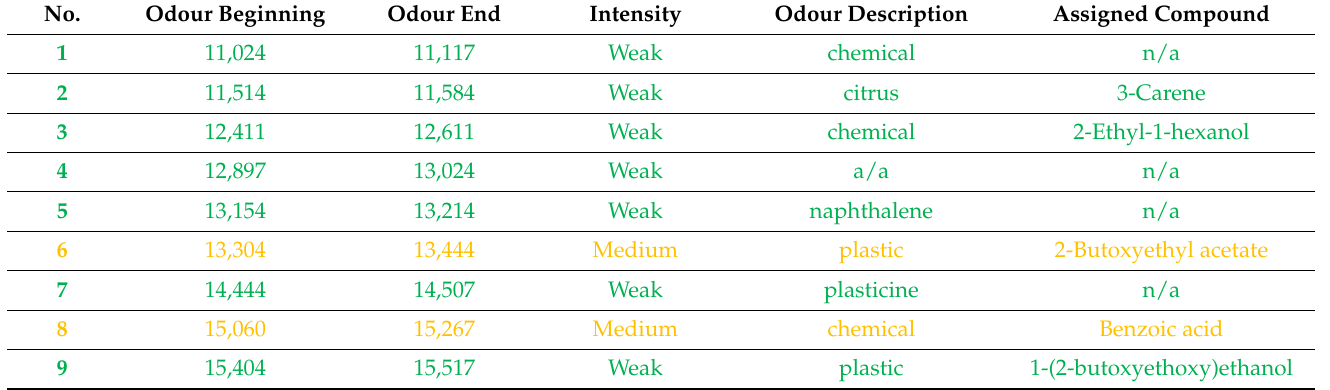
3.2. Samples of Floor Staves in the Emission Chamber Figure 7 and Table 3 show the test results obtained for the air sample collected in an emission chamber, where the floor staves were placed. Two air samples were collected three days into their seasoning, but only one representative spectrum was selected for a detailed analysis. The chromatographic spectra of both collected samples differed slightly (minor differences in the intensity of individual peaks).